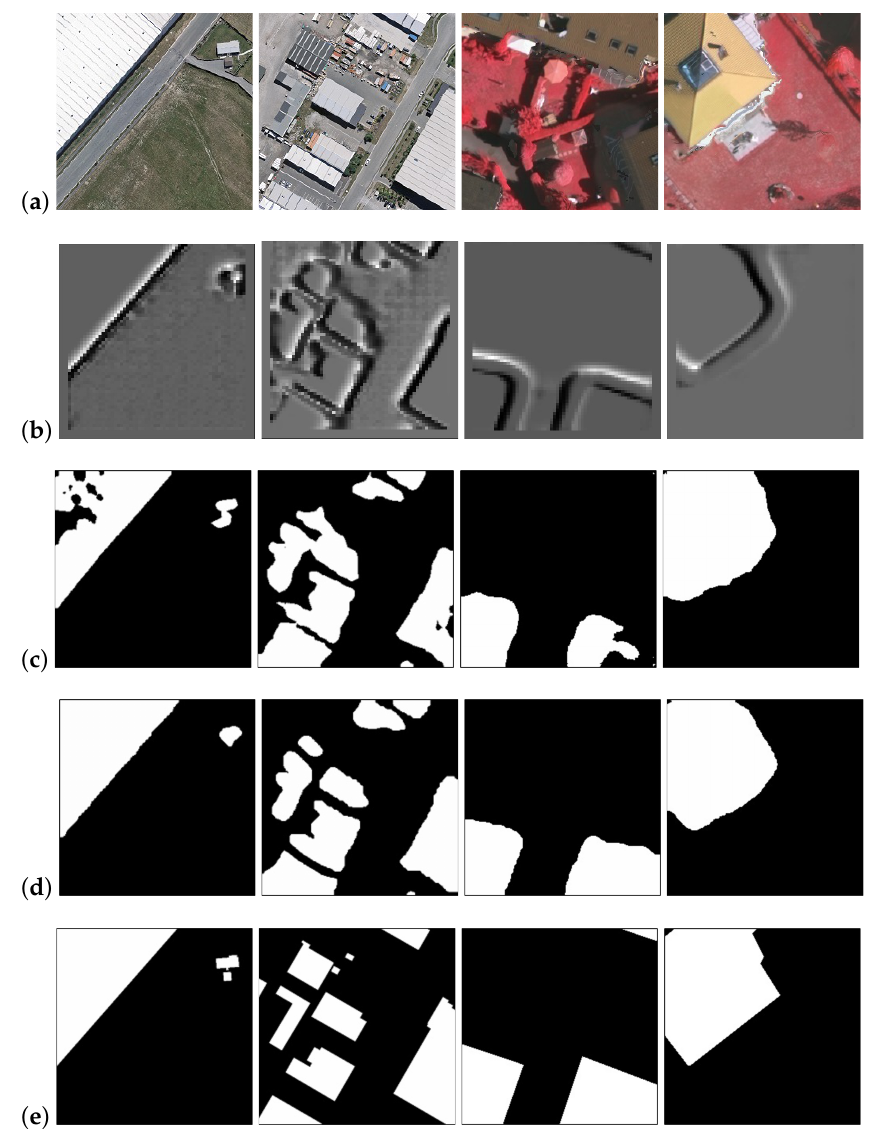
Figure 7. Performance visual analysis of structure affinity on WHU and Vaihingen data sets. Among them, the first two columns are the visual comparison results on the WHU data set, and the latter two columns are the visual comparison results on the Vaihingen data set. ( a ) Input the target domain images. ( b ) The visualization results for the affinity in a certain direction. Affinity presents a good performance in describing the class consistency between pixels. ( c ) Segmentation result of baseline, in which a decent object localization map is obtained but building edges are poorly segmented. ( d ) CDSA utilizes the structure affinity of pixels for refining the buildings. ( e ) Ground